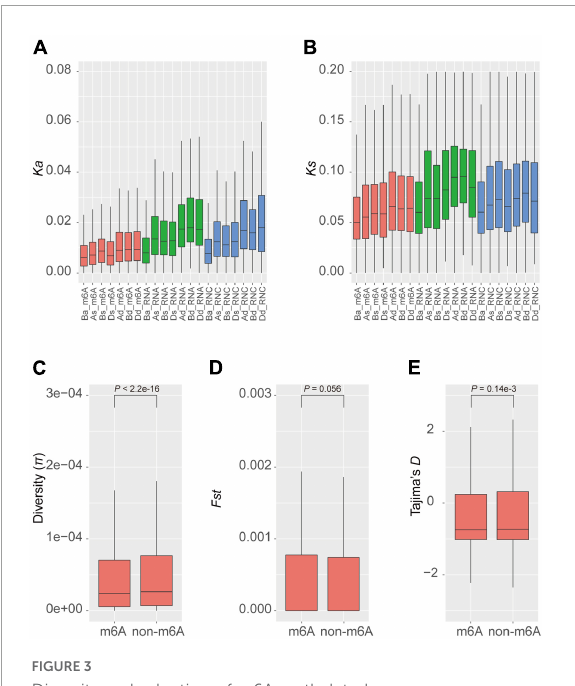
FIGURE3 Diversity and selection of m6A methylated